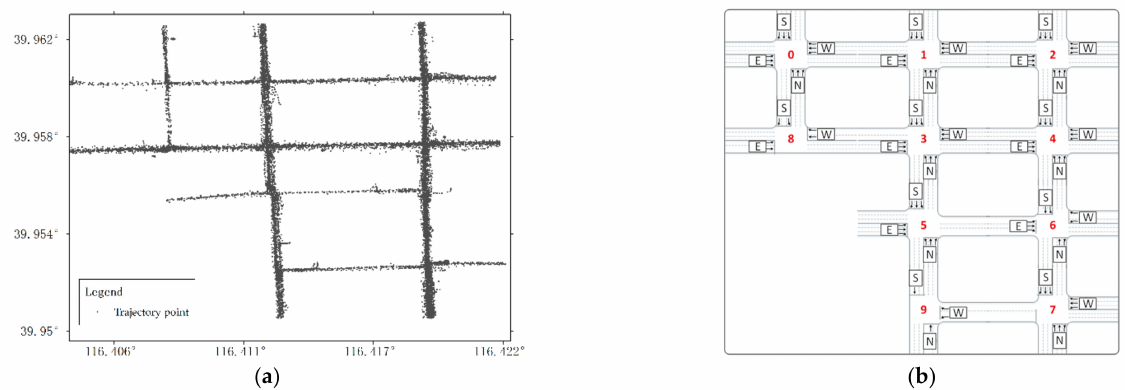
Figure 2. Diagram of intersection area; ( a ) trajectory points; ( b ) topology of intersection. Due to the block of GPS signal and the error of hardware/software in the process of data collection and transmission, there may be some errors in the original floating car data.